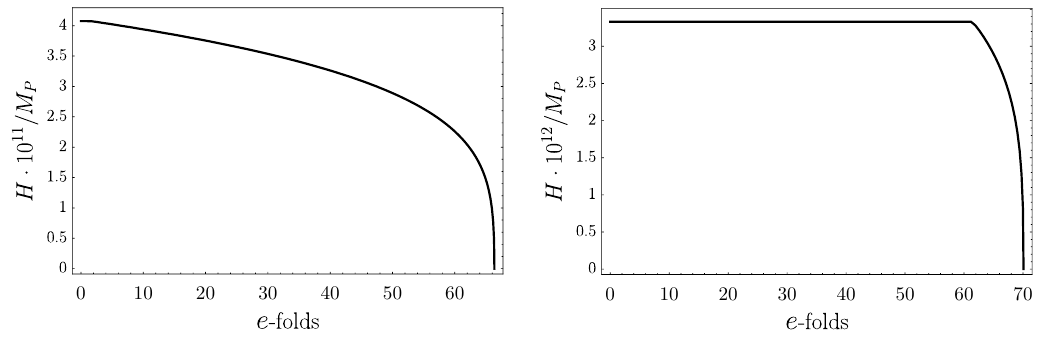
Figure 3 . Evolution of the Hubble parameter for set 1 (left) and set 2